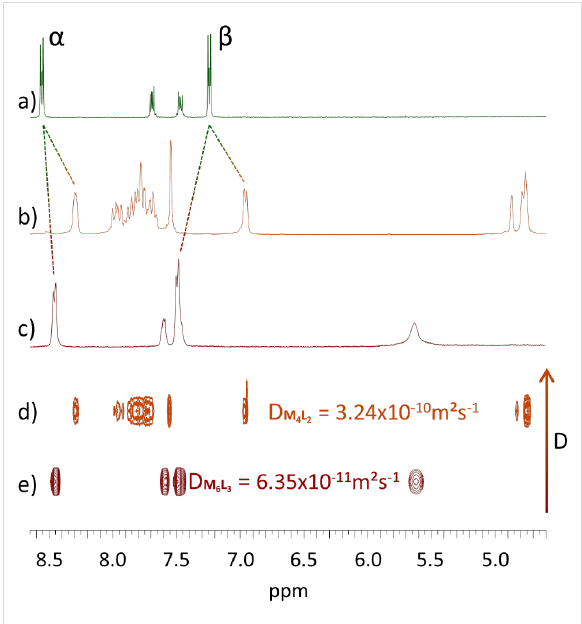
phenyl units (dppf) and pyridyl groups result in an upfield shift of their signals (Figure 2b) compared to L1, the pyridyl protons are in this case shifted downfield (Figure 2c), as expected